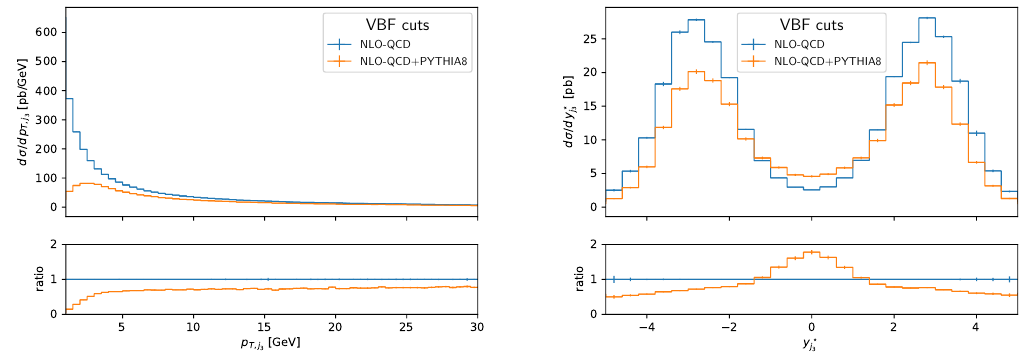
variable of the third-hardest jet jet 3